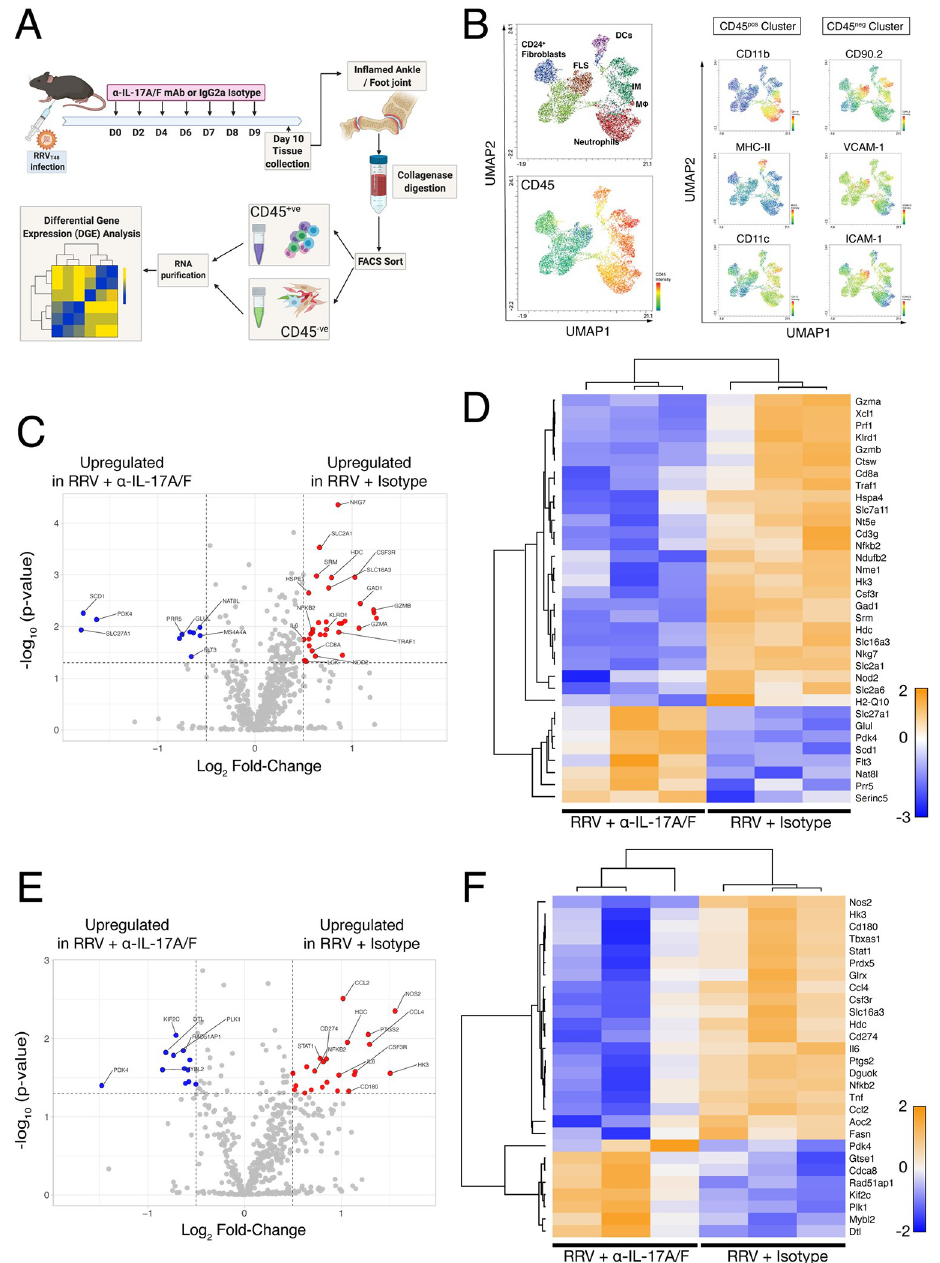
Fig 11. Treatment with anti-IL-17A/F monoclonal antibody shifts transcriptional profile of the musculoskeletal microenvironment in RRV infection. A) Schematic of isolation of CD45 + and CD45 - musculoskeletal cells from RRV-infected C57BL/6J mice treated with anti-IL-17A/F or IgG2a isotype control antibodies at day 10 post-infection prior to cell sorting and Nanostring analysis. Gating strategy for CD45 + and CD45 - cell sorting shown in S6 Fig. B) Flow cytometry analysis of musculoskeletal CD45 + and CD45 - compartments from RRV-infected C57BL/6J mice at 10 dpi visualized with UMAP dimensional reduction. CD45 intensity shown as per intensity heatmap, and expression intensity of CD11b, MHC-II and CD11c, and CD90.2, VCAM-1 and ICAM-1 shown for CD45 + and CD45 - clusters, respectively. C) Volcano plot of differentially expressed genes in the CD45 + compartment isolated from the feet of RRV-infected mice C57BL/6J treated with anti-IL-17A/F or isotype control at 10 dpi (blue dots = genes upregulated in anti-IL-17A/F-treated mice compared to isotype-treated mice; red dots = genes upregulated in isotype-treated mice compared to anti-IL-17A/F-treated mice). D) Heatmap of unsupervised hierarchical clustering of differentially regulated genes in the CD45 + compartment in the feet of RRV-infected C57BL/6J mice treated with anti-IL-17A/F or isotype control, at 10 dpi. E) Volcano plot of differentially expressed genes in the CD45 - compartment isolated from